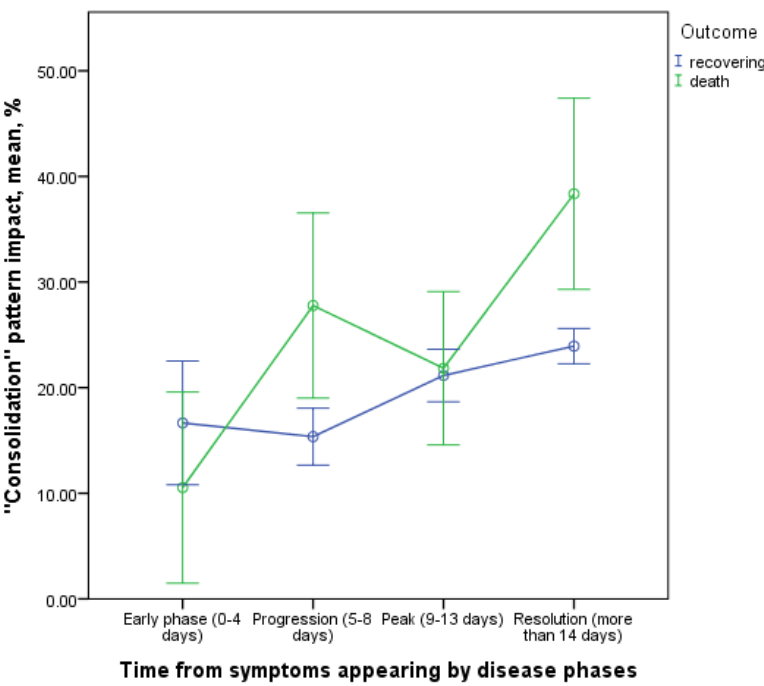
Figure 12. Contribution of the consolidation pattern to CT picture in the affected areas.